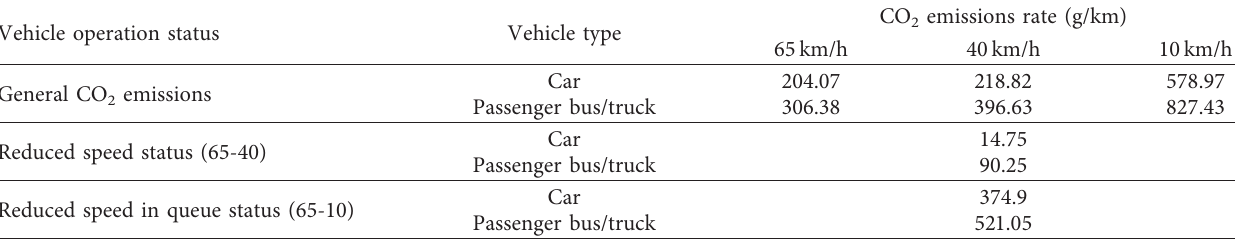
Table 1: Speed reduced CO